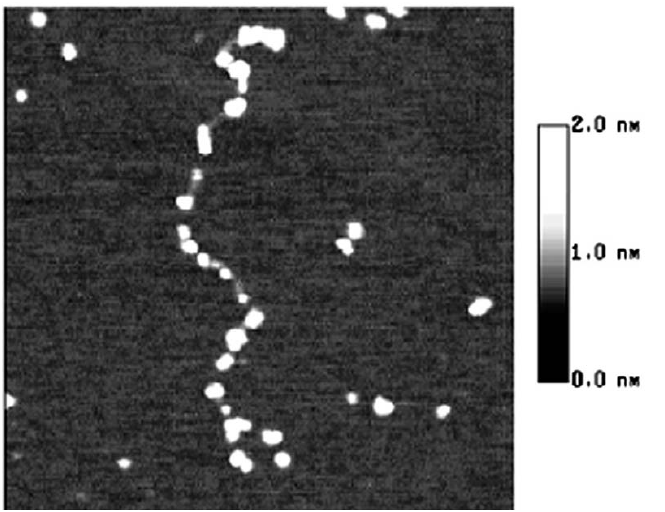
Figure 3. The AFM image of starch nanochains when heated in 100 °C water bath for 10 min, size 600 × 600 nm.